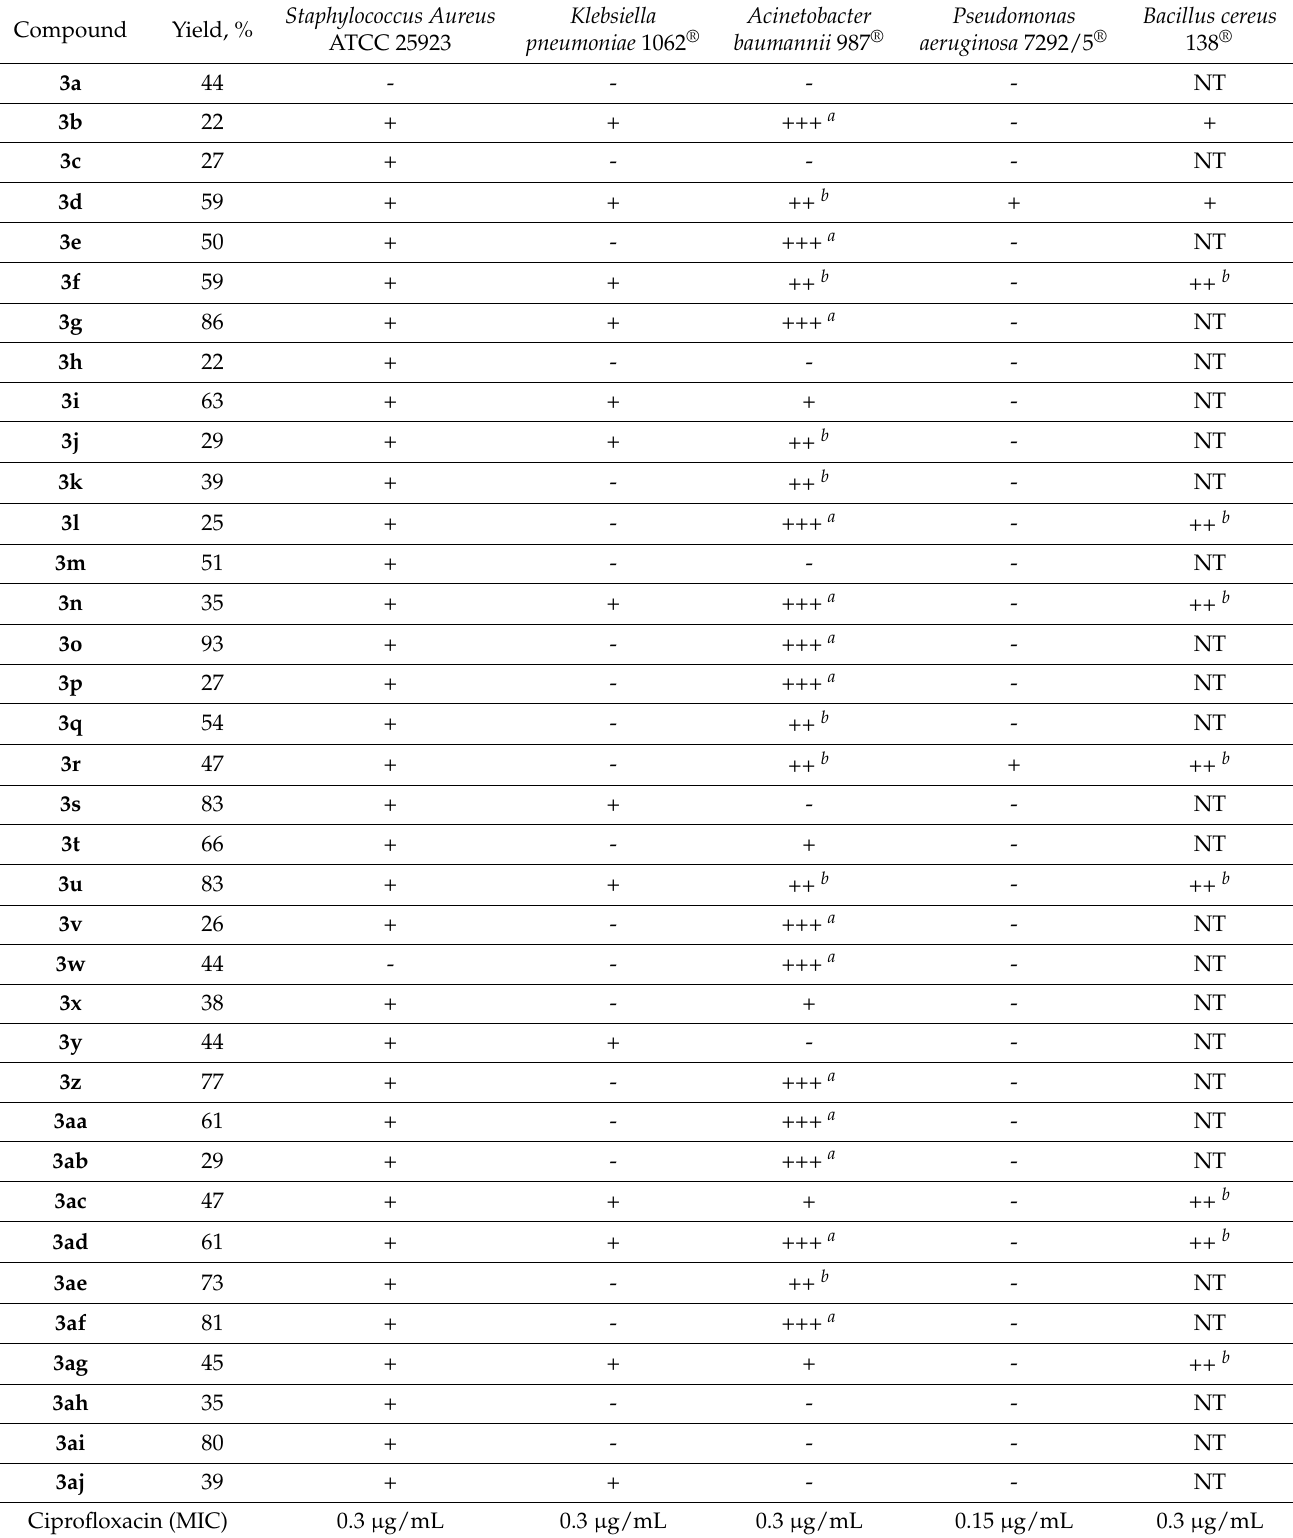
Table 1. Antibacterial activity (MIC, mg/mL) of compounds 3a – aj against five bacterial strains in comparison with ciprofloxacin (-: no activity; +: active but MIC is higher than that of